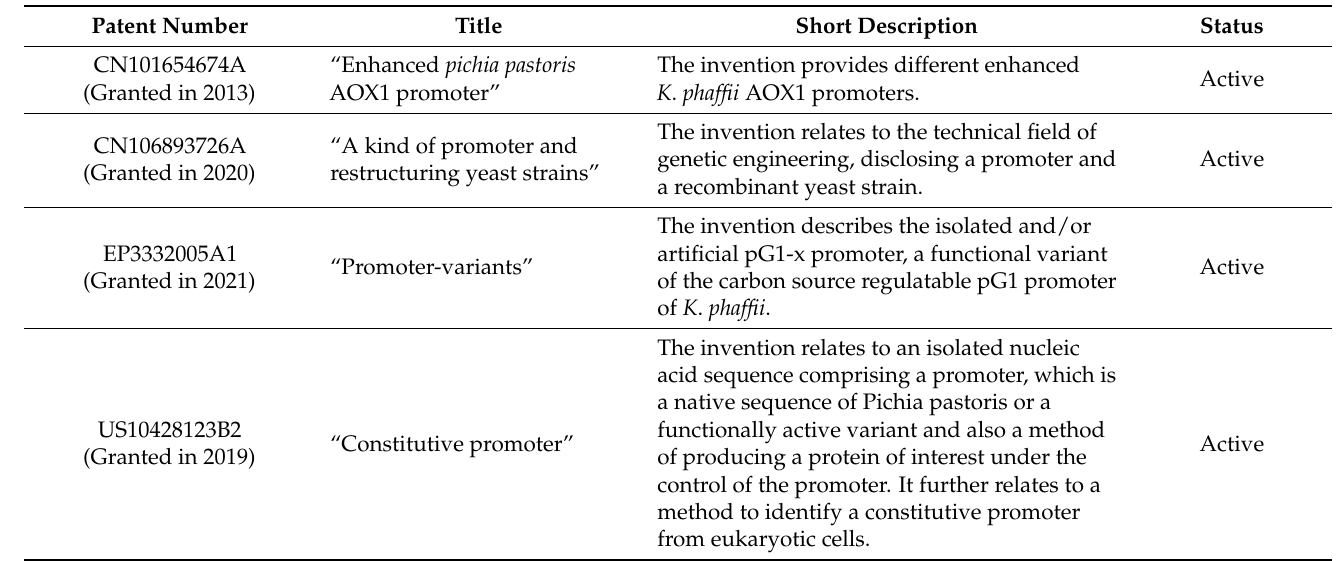
Table 2. Exemplary patents protecting inventions for yeast promoters, especially those for K. phaffii . Active patents are listed, excluding those pending, expired, or abandoned. Sources: Espacenet [61], and Google Patent [62].